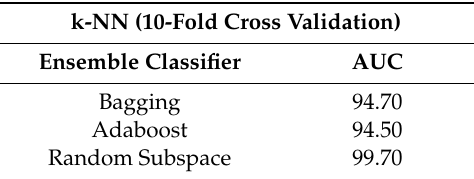
Table 3. Area under Curve (AUC) evaluation of ensemble with k-NN base classifier.